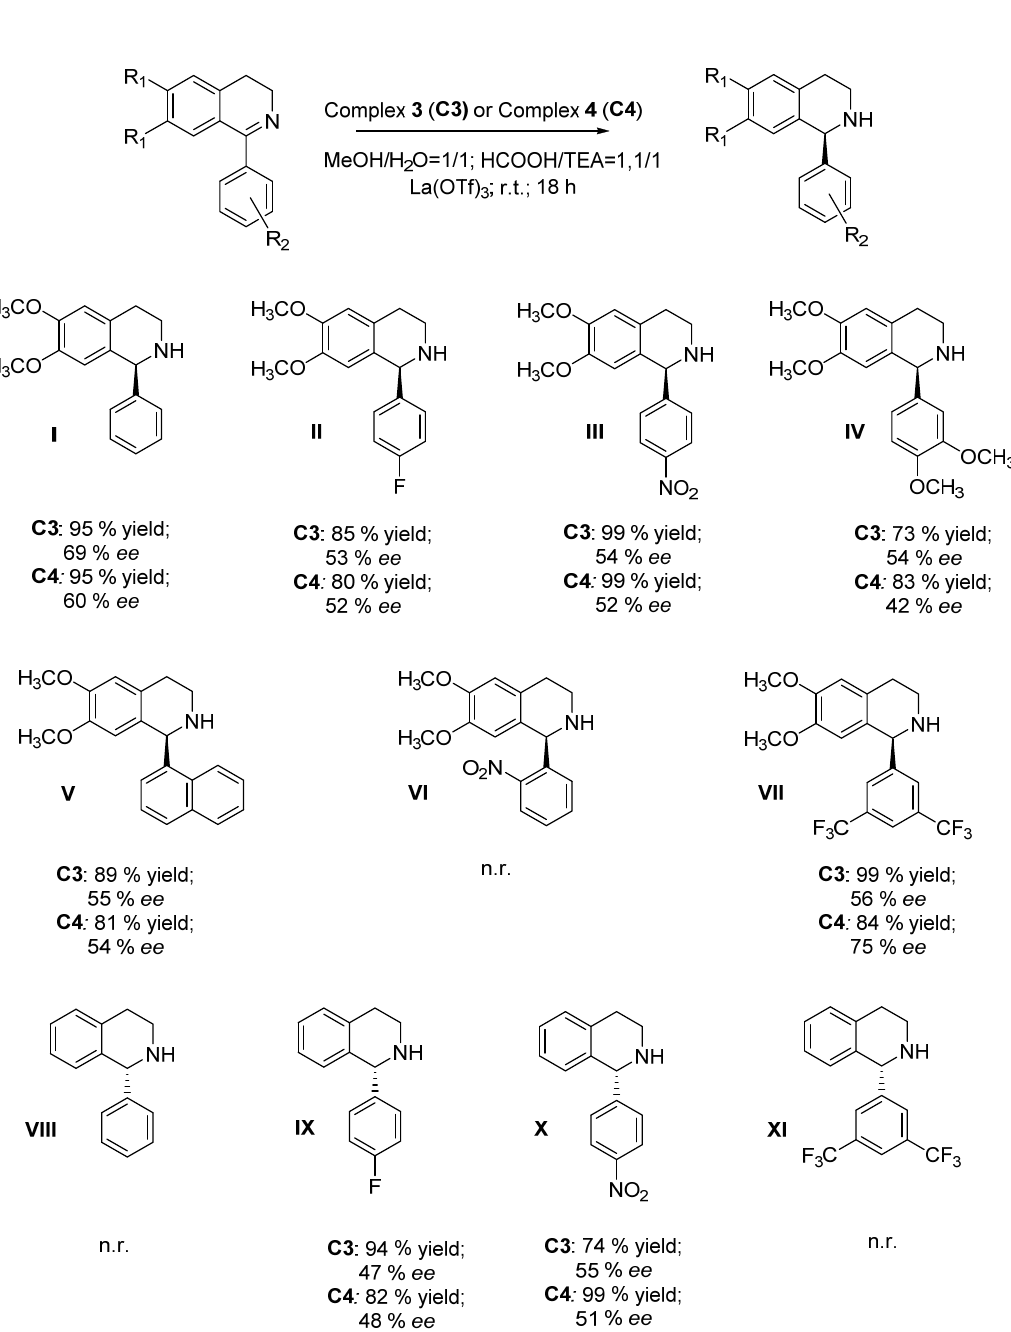
Figure 2. ATH of different 1-aryl imines using C3 and C4 as catalysts. n.r. = no reaction.